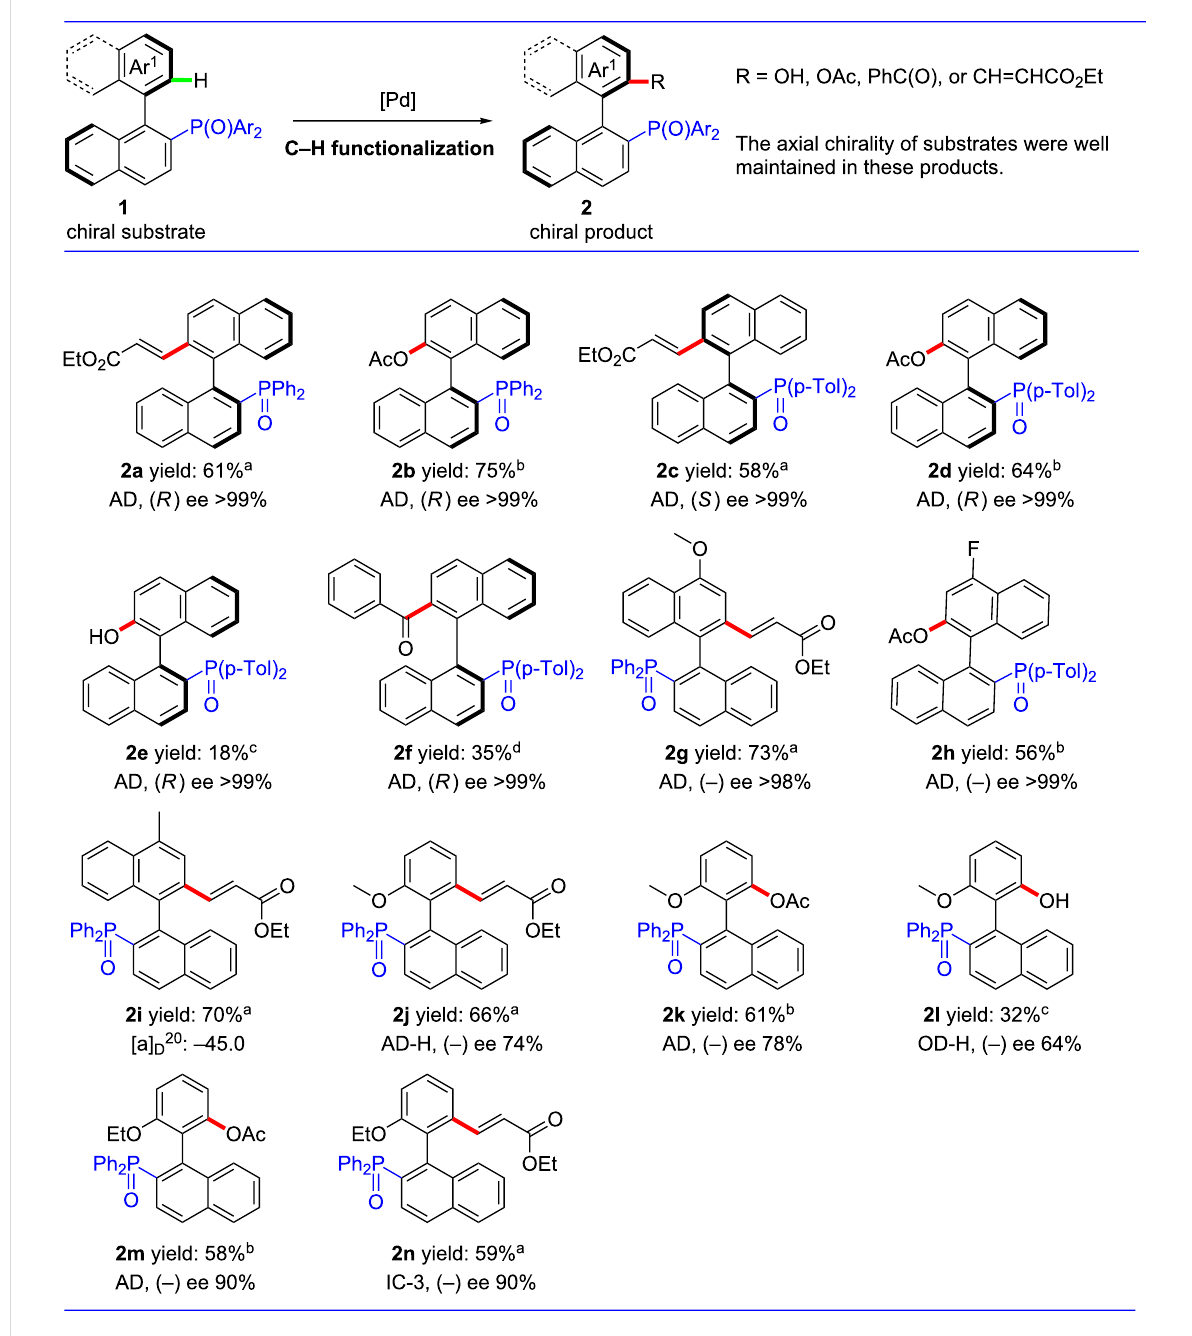
Figure 1: C–H functionalization of axially chiral phosphorus substrates. The yields are isolated yields and the ee values are determind by HPLC. a Reaction conditions: substrate (0.3 mmol), ethyl acrylate (1.5 mmol), Pd(OAc) 2 (10 mol %), Ac-Gly-OH (20 mol %), AgOAc (1.5 mmol), TFE (3.0 mL), 100 °C, 24 h, air atmosphere; b Substrate (0.3 mmol), PhI(OAc) 2 (0.9 mmol), Pd(OAc) 2 (10 mol %), TFE (3.0 mL), 100 °C, 24 h, air atmos- phere; c Substrate (0.3 mmol), TBHP (1.2 mmol), benzyl alcohol (0.75 mmol), Pd(TFA) 2 (10 mol %), DCE (3.0 mL), 60 °C, air atmosphere; d Substrate (0.3 mmol), PhI(TFA) 2 (0.45 mmol), Pd(OAc) 2 (10 mol %), MeNO 2 (3.0 mL), 60 °C, 24 h, air